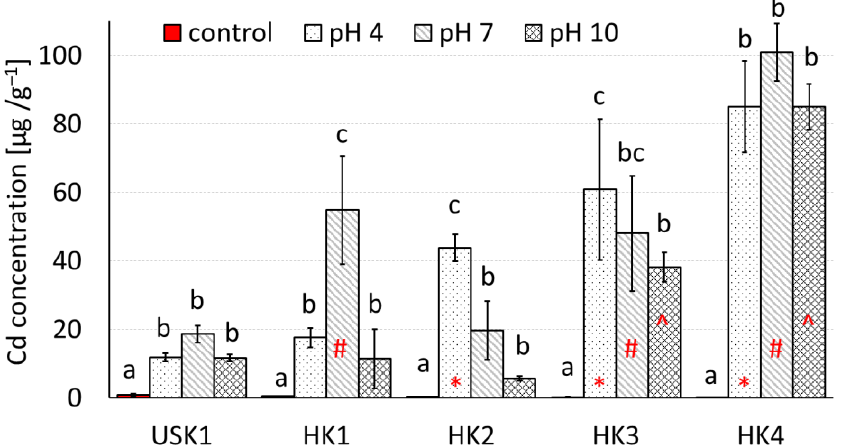
Figure 3. Cd accumulation (mean ± SD; µ g g − 1 ) in the biomass of bacterial strains isolated from the phosphate ore (HK1–HK4 strains) and B. subtilis USK1 reference strain after incubation (20 min; 28 ◦ C; pH 4 or 7 or 10) with the ore from Djebel Onk. The same letter (a, b, c) in a particular strain denotes no significant differences among pH groups. The red marks mean the differences between each native strain and the reference strain USK1 at pH4 (*), pH7 (#), and pH10 (ˆ) analyzed separately (ANOVA, LSD; p <